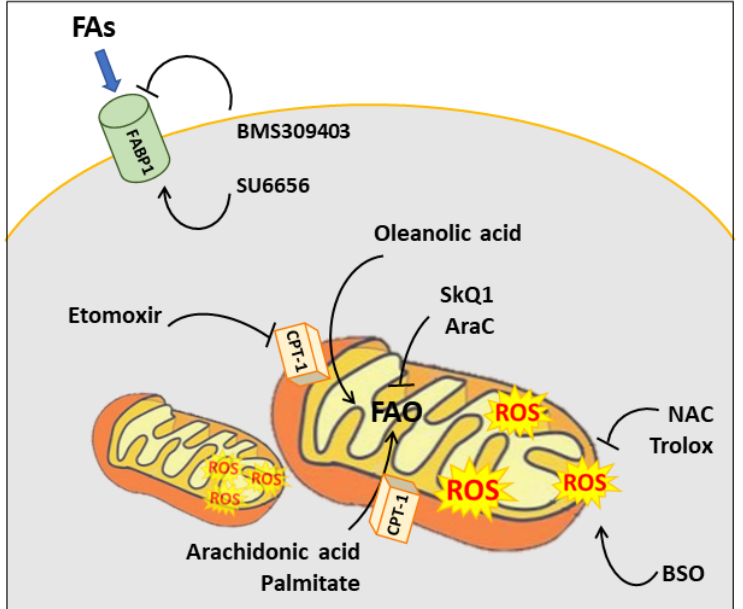
Figure 3. A schematic representation of the mechanism of action exploited by the different com- pounds mentioned.